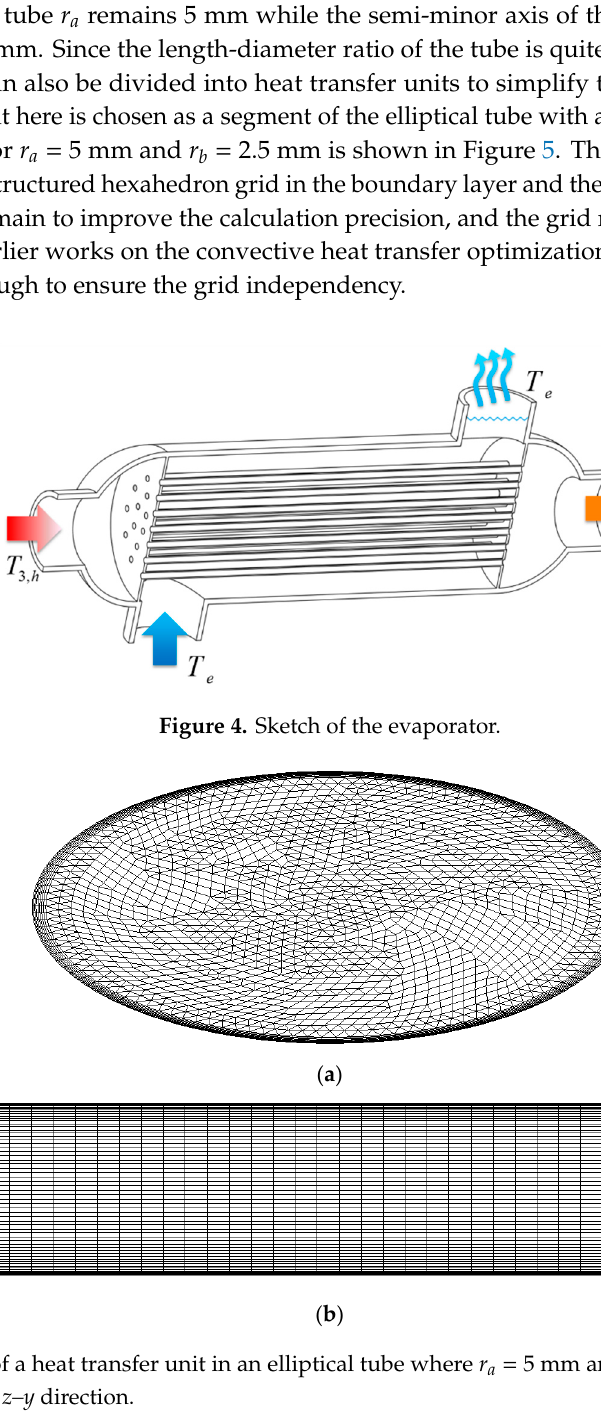
Figure 5. Grids of a heat transfer unit in an elliptical tube where r a = 5 mm and r b = 2.5 mm: ( a ) x–y direction and ( b ) z–y direction.